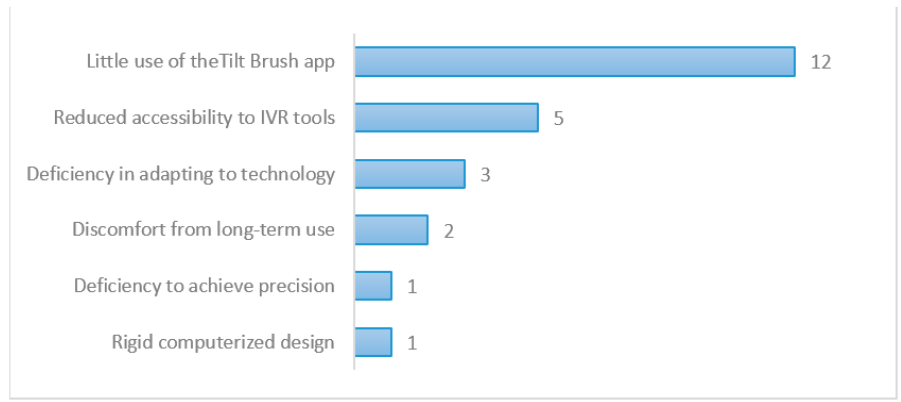
Figure 11. The most highly rated disadvantages of using IVR in design, according to teachers.